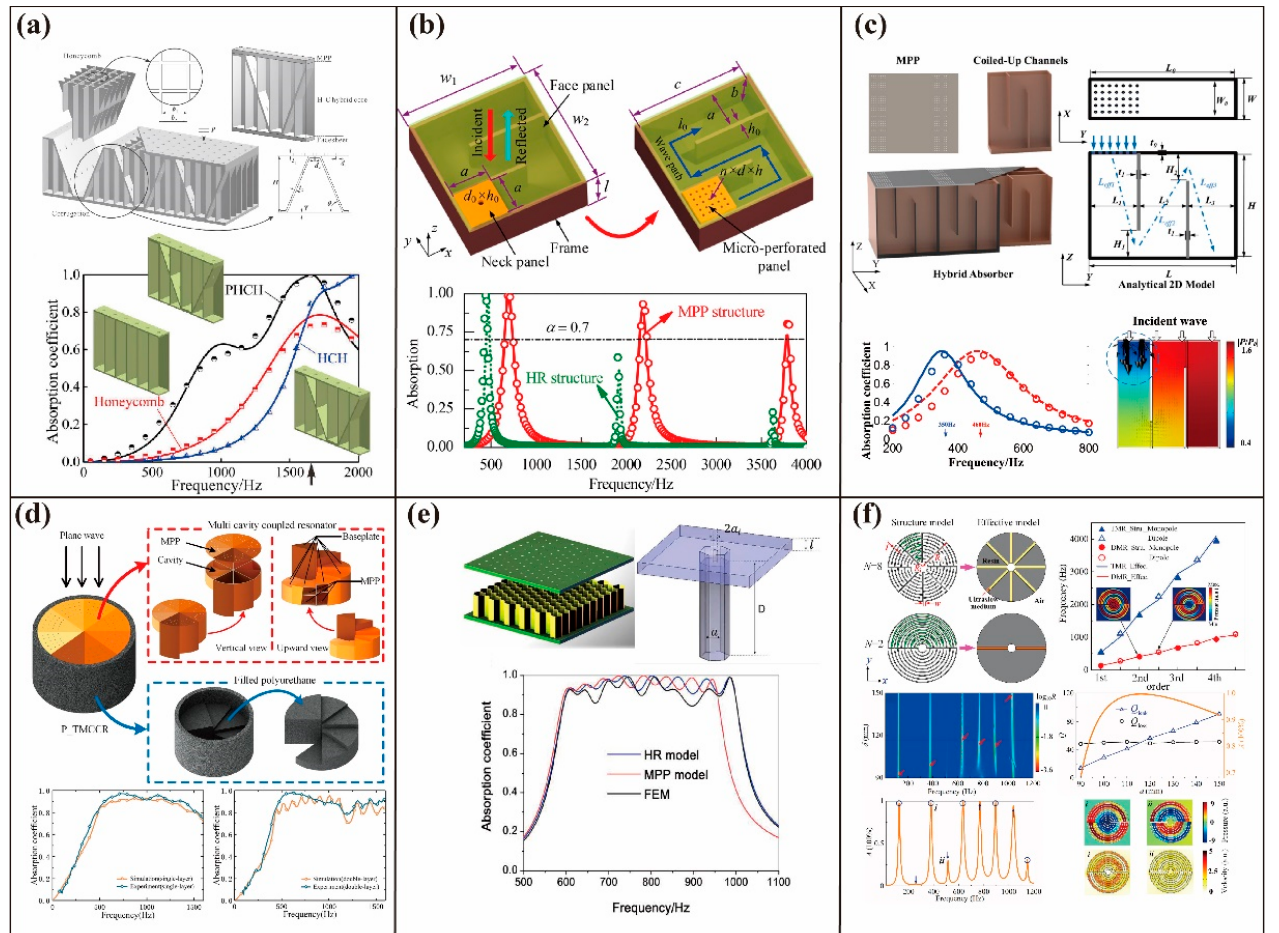
Figure 8. ( a ) Schematic of perforated honeycomb-corrugation hybrid (PHCH) metamaterial [116]. ( b ) Schematic of the broadband metamaterial unit [115]. ( c ) Schematic diagram of a hybrid absorber with microperforated plates and coiled channels [119]. ( d ) Schematic representation of a tunable multi-cavity coupled-resonator with polyurethane-filled slits [121]. ( e ) Schematics of the composite honeycomb sandwich panels [117]. ( f ) Multiband quasi-perfect low-frequency sound absorber based on double-channel Mie resonator [113].